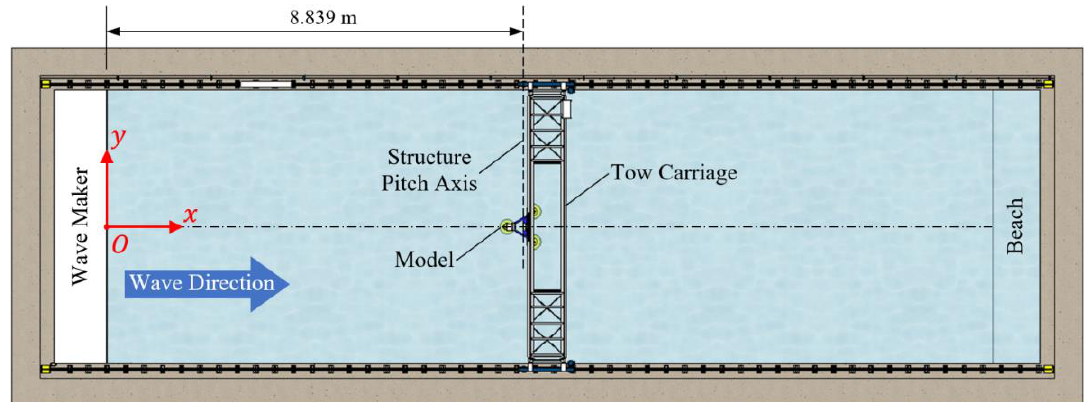
Figure 3. Global basin coordinate system and general basin arrangement. The dimension is in model scale. The pitch axis of the model structure is 0.1506 m (model scale) below the still water level (SWL). The position of the model in the basin is not drawn to scale. Illustration adapted with permission from Matthew Fowler, 1/50-scale DeepCwind semi-submersible component wave testing [5]; published by the University of Maine, 2021